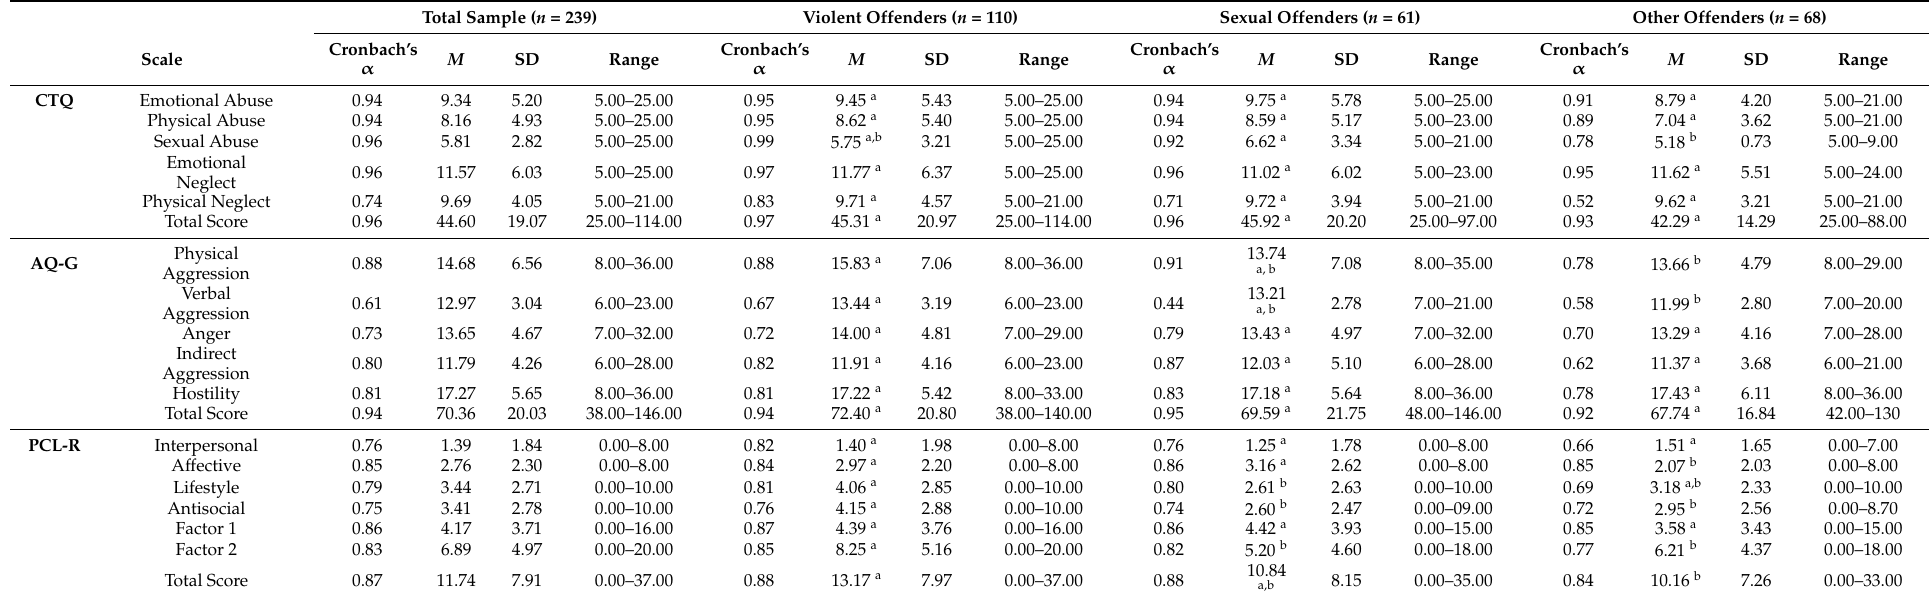
Table 1. Distribution of Variables of Interest in the Total Sample and in Offender